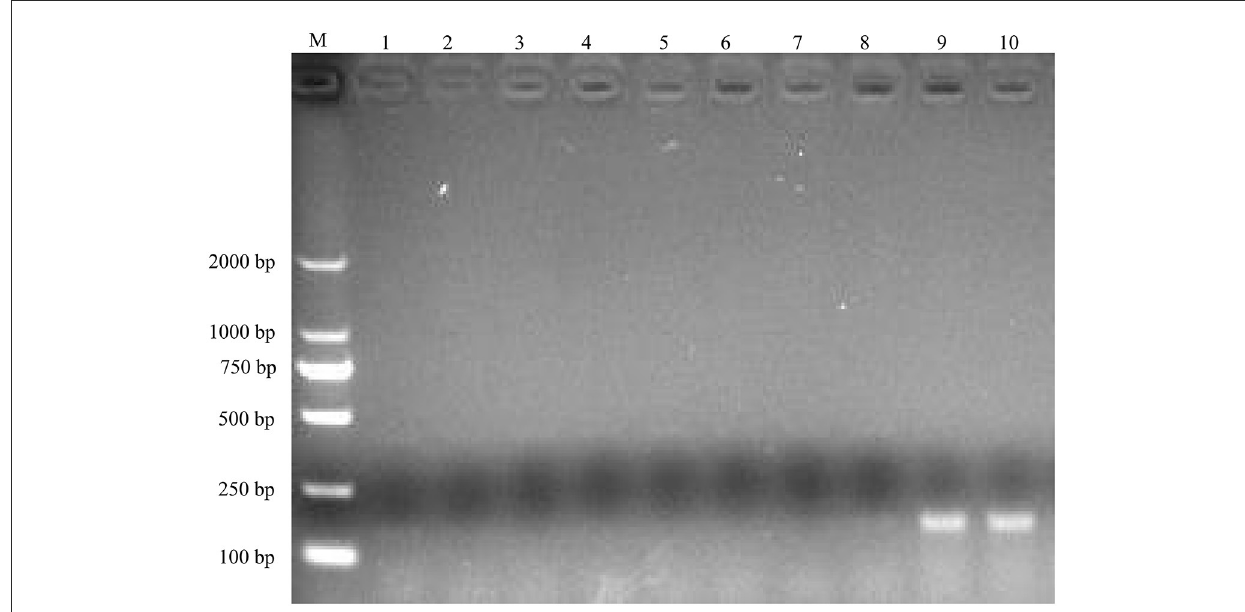
FIGURE2 Agarose gel electrophoresis results for RT-PCR product of the potential causative agents. M, DL2000 DNA Ladder; lane 1, 2, MDRV; lane 3, 4, DHAV-1/DHAV-3; lane 5, 6, NDV, lane 7, 8, DTMUV; lane 9, 10, NDRV.